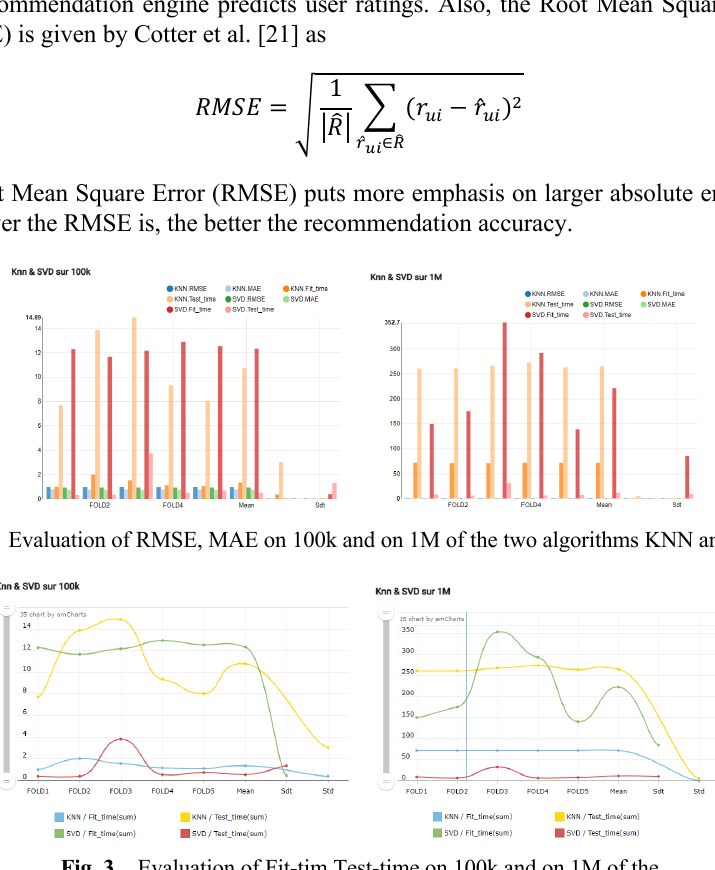
Fig. 3. Evaluation of Fit-tim Test-time on 100k and on 1M of the two algorithms KNN and